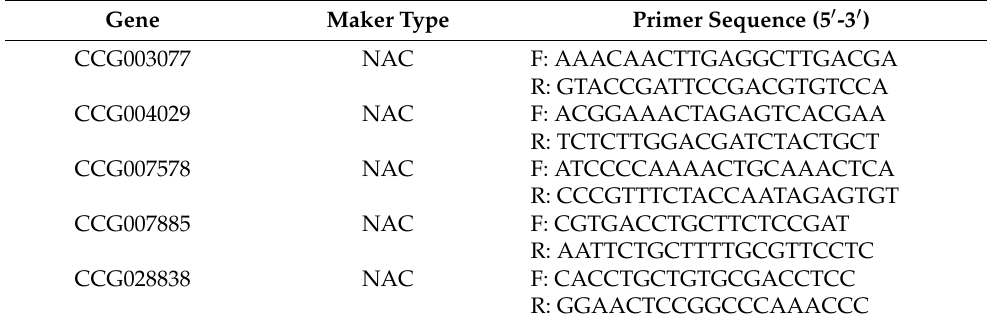
Table 2. NAC gene primer